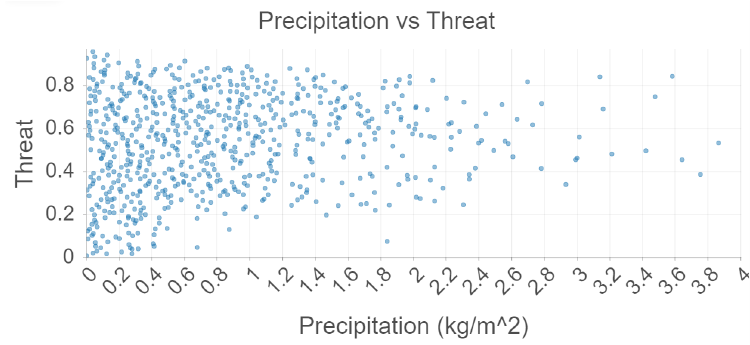
Figure 6. Precipitation and Threat analysis using Random Forest.